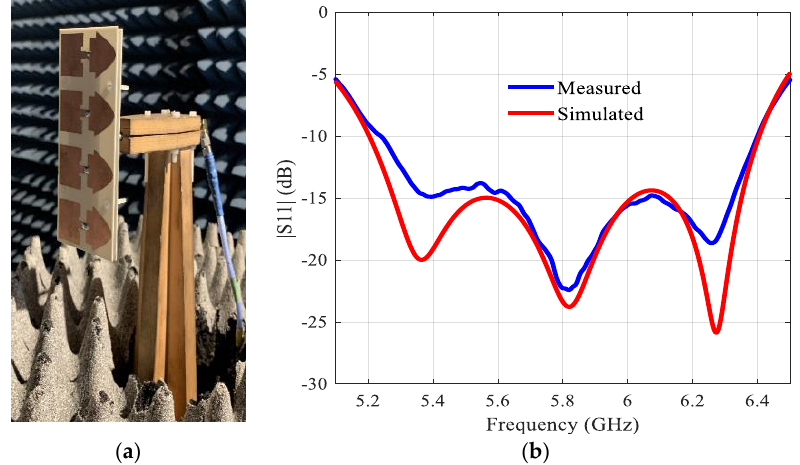
Figure 17. ( a ) Prototype of the 2 × 4 array, ( b ) Simulated and measured reflection coefficients (|S11|) of the integrated structure including the feeding network.